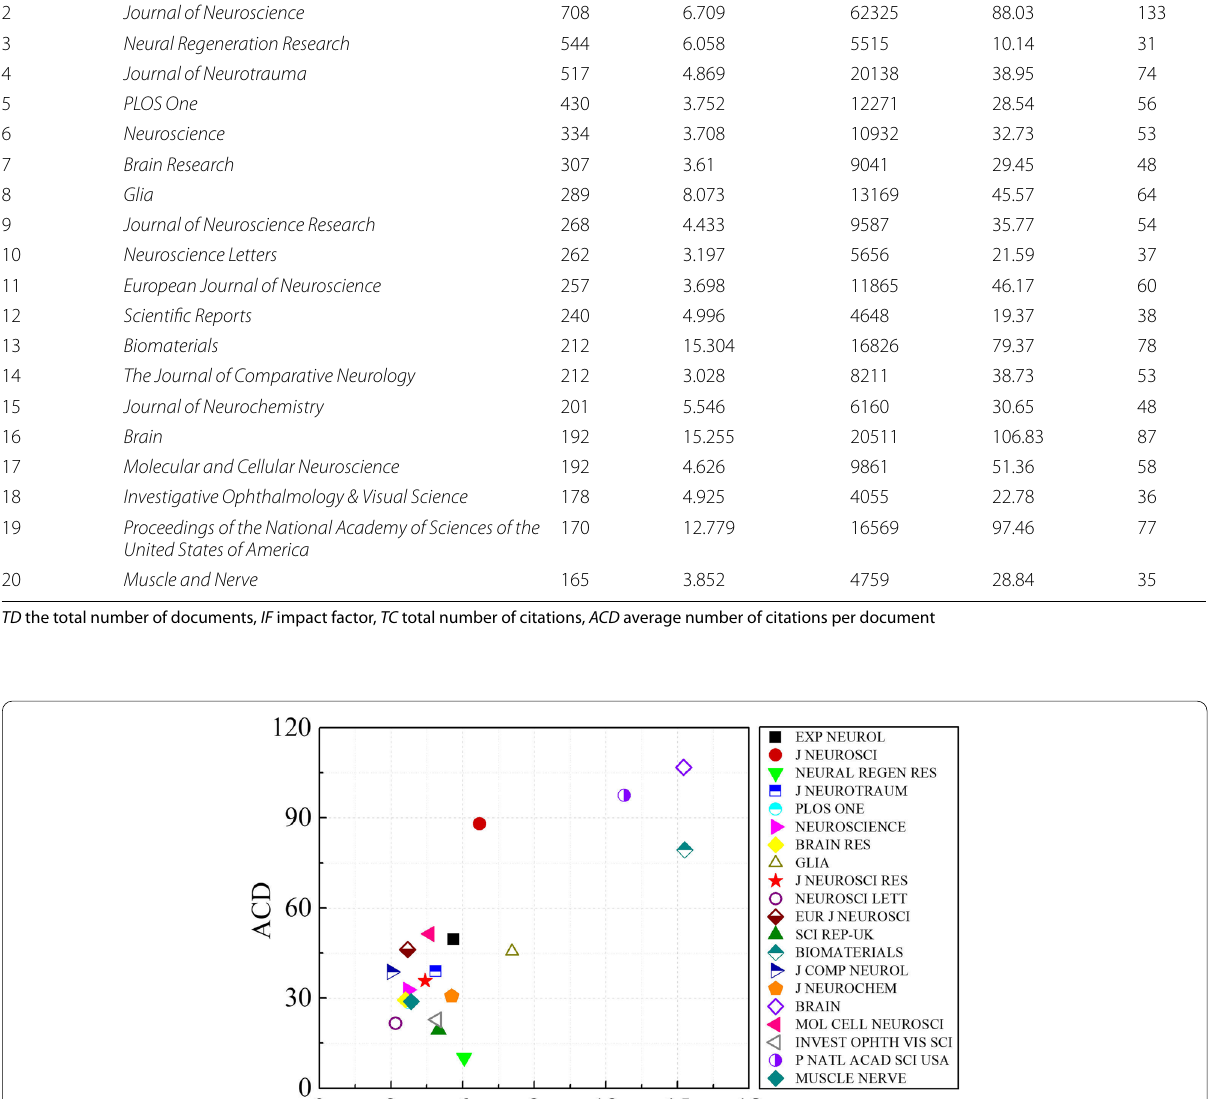
Table 2 The top 20 journals in the field of axonal regeneration by TD No.